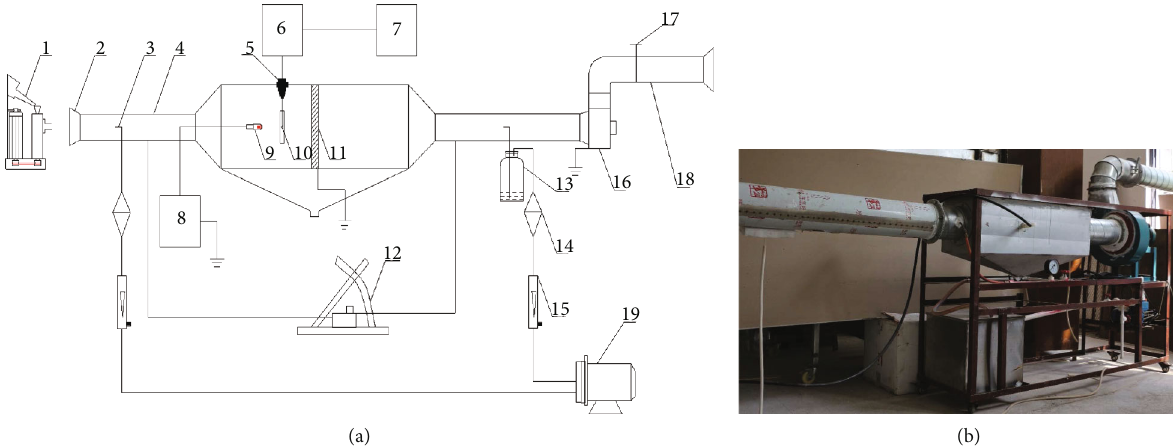
Figure 1: (a) Schematic diagram of vibrating string fi lter with charged water mist: 1. dust generator; 2. current collector; 3. sampling head; 4. air inlet pipe; 5. high-voltage insulator; 6. high-voltage power supply; 7. control cabinet; 8. pressurized spray system; 9. nozzle; 10. annular electrode corona; 11. vibrating grid; 12. inclined pressure gauge; 13. sample bottle; 14. fi lter cartridge; 15. rotor fl ow meter; 16. fan; 17. air fl ow control valve; 18. air exhaust pipe; and 19 suction pump. (b) Physical test model photo of vibrating string fi lter with charged water